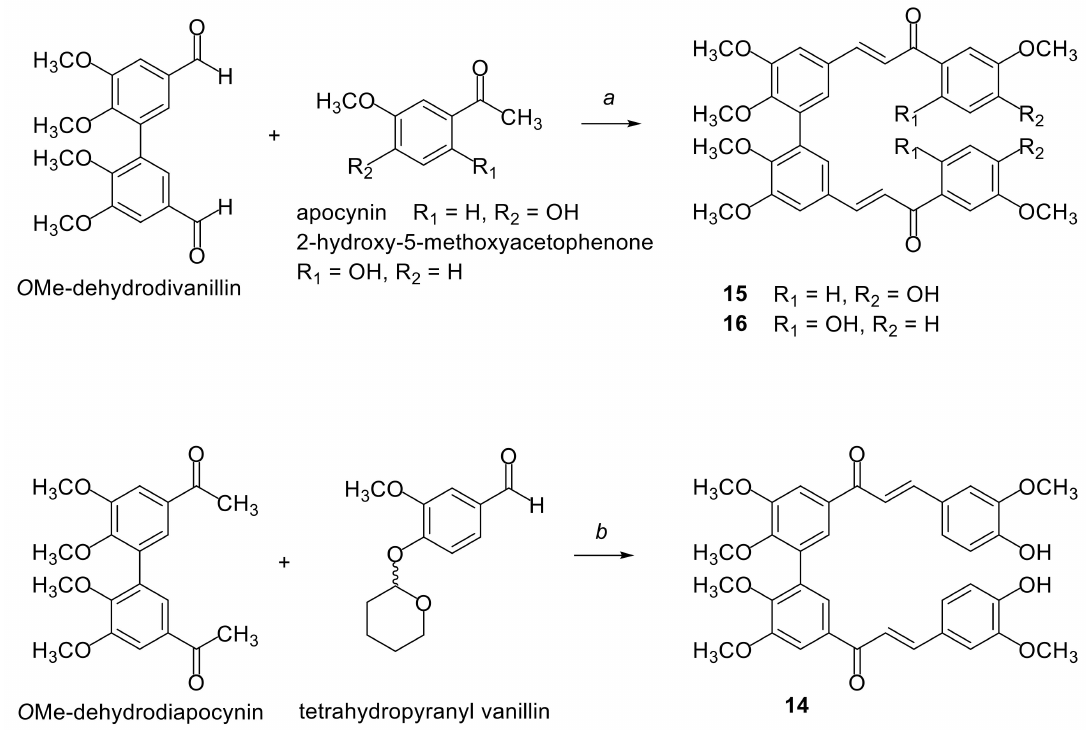
Scheme 2. Reagents and conditions: ( a ) KOH / H 2 O, MeOH, 3 h at 0 ◦ C, then 96 h at rt; ( b ) KOH / H 2